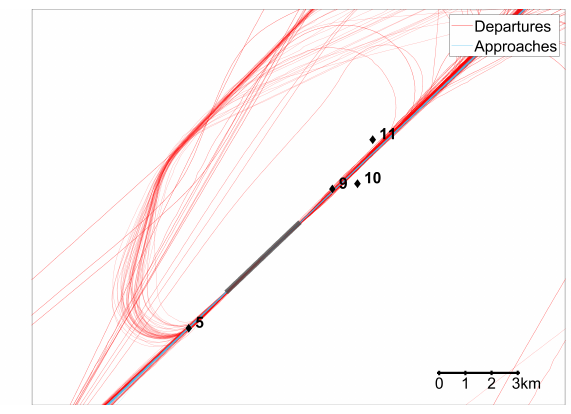
Figure 2: NMT positions at Geneva airport with flight tracks.